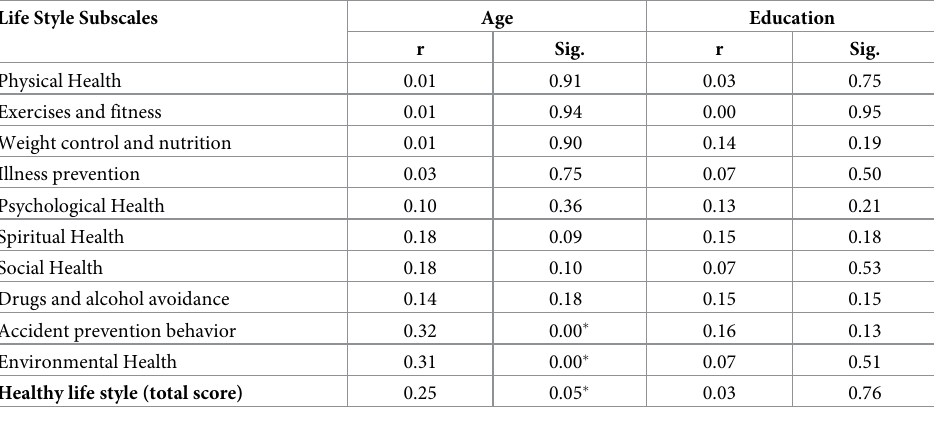
Table 4. Correlations of LSQ and its subscales with age and education.